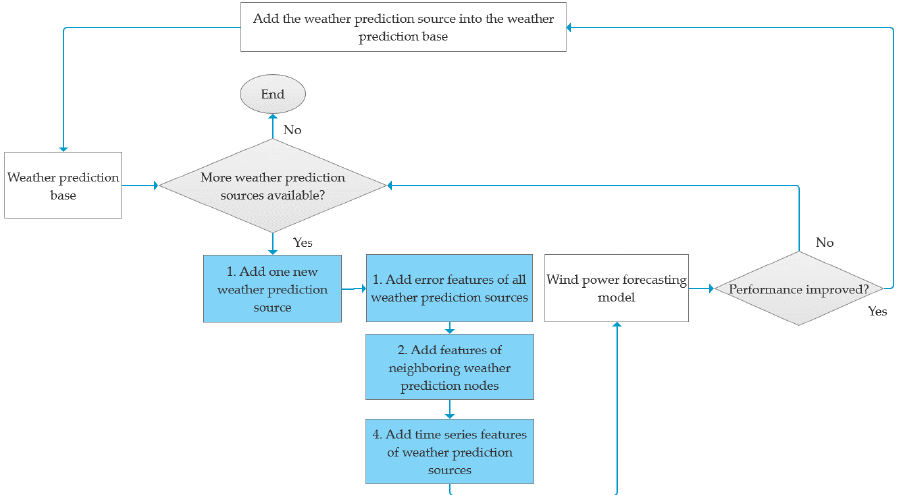
Figure 2. The framework of the data enrichment method.